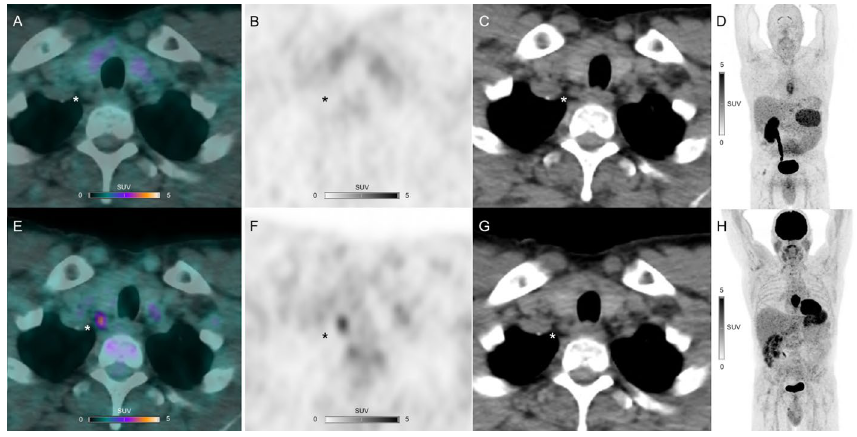
Fig. 1 68 Ga-NODAGA-RGD PET/CT ( A ), PET ( B , D ) and CT ( C ) and 18 F-FDG PET/CT ( E ), PET ( F , H ) and CT ( G ) views of an upper paratracheal lymph node metastasis (asterisks) showing no increased 68 Ga-NODAGA-RGD uptake but intense 18 F-FDG uptake (SUV max 3.9 g/mL) in a 59-year-old participant with esophageal squamous